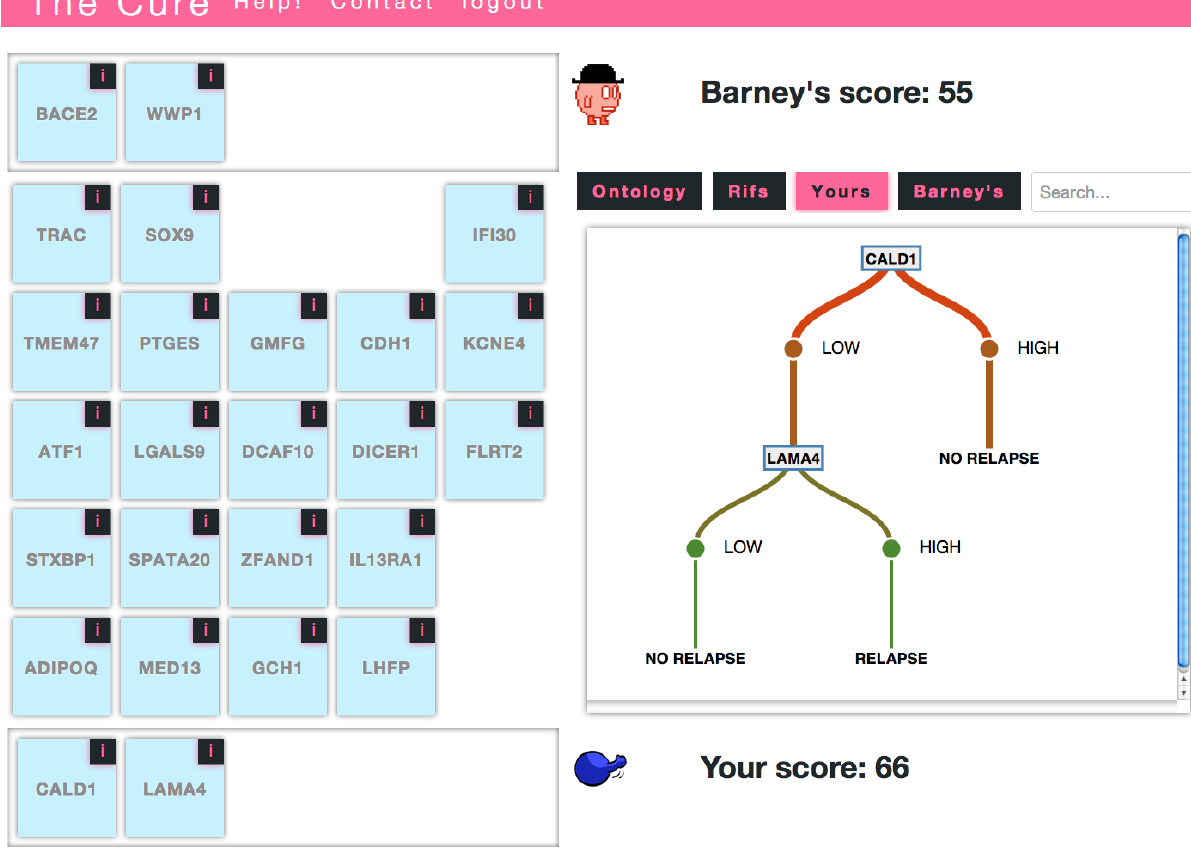
a gene card from the board and adding it to their hand. The player with the highest score after 5 turns is the winner. The tabbed display provides gene annotations ("Ontology", "Rifs") and views of decision trees constructed by the system using the selected genes. The scores reflect the predictive power of the selected genes. The system produces these scores by using data associated with the selected genes to train and test a decision tree classifier. The scores are the accuracy of these inferred